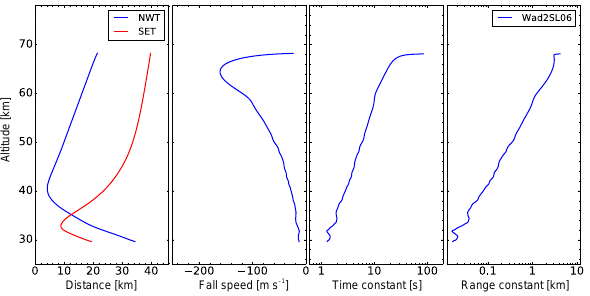
Figure 3. From left to right: distance between the starute and the lidar beams for the two telescopes (NWT: blue, SET: red); fall speed of the starute; time constant τ and range constant (cid:49)z τ as defined in the text.